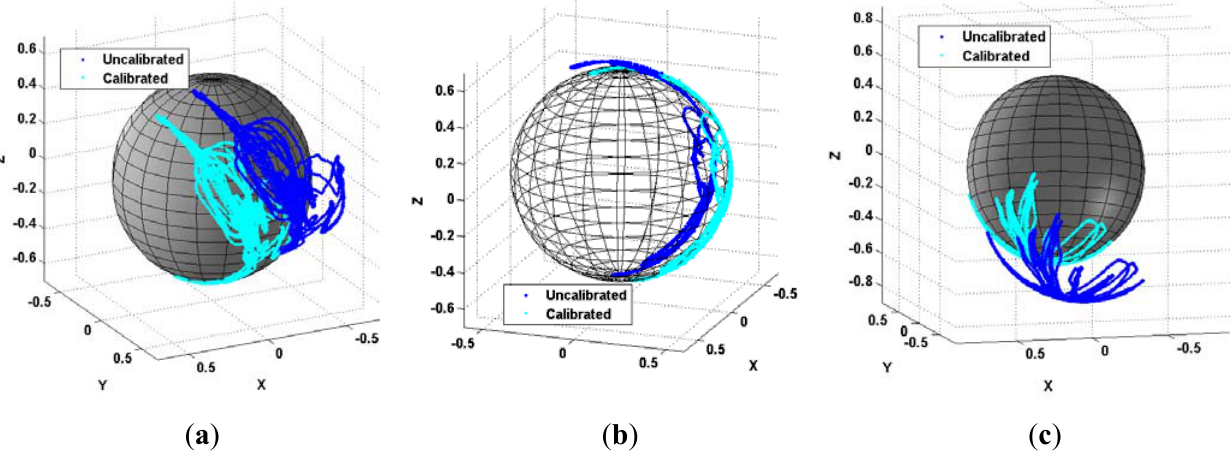
Figure 12. Biased and distorted magnetic field observations (blue) are calibrated resulting in the nearly ideal observation sphere (cyan) for the magnetometers embedded in IMUs attached to the left foot ( a ), the right foot ( b ) and the shoulder ( c ).